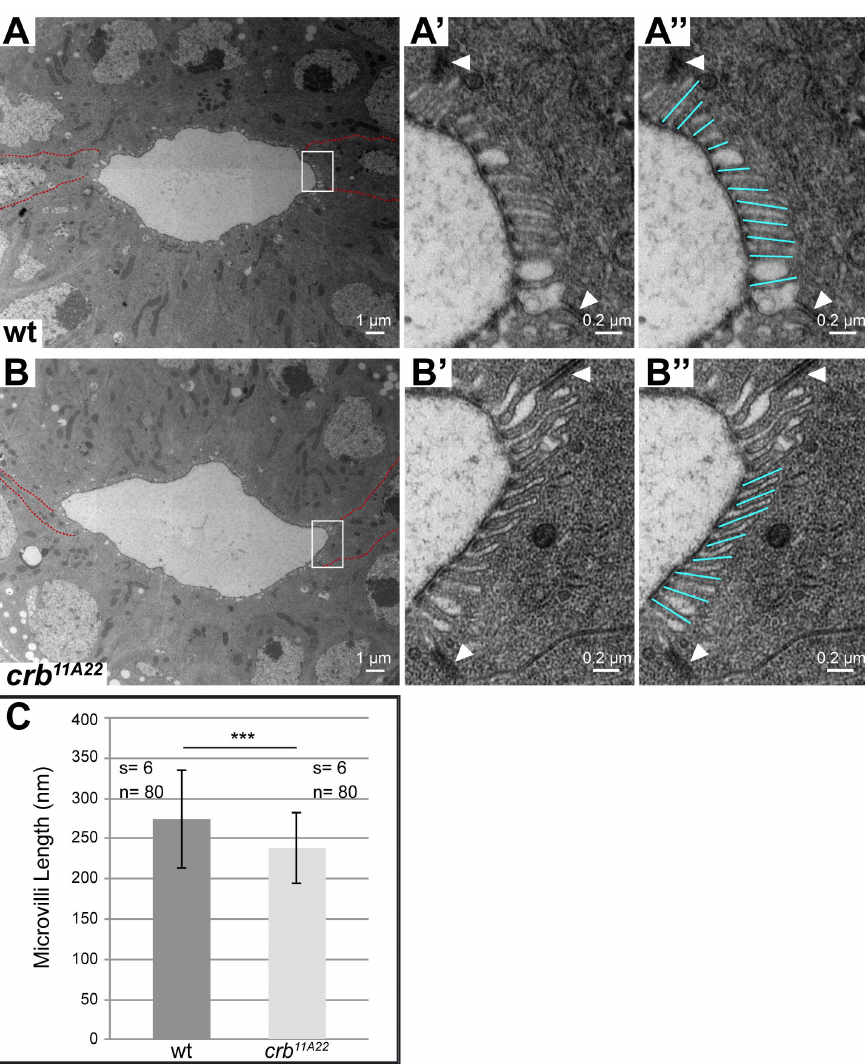
Figure 5. Loss of Crb from the BCs alters the apical membrane structure. ( A–B 0 ) Electron micrographs of cross sections through the large intestines of stage 16 wild-type (A–A 0 ) and homozygous mutant crb 11A22 (B–B 0 ) embryos. In A and B, BCs are outlined by red lines, the rectangles indicate areas enlarged in A 9 , A 0 , B 9 and B 0 . White arrowheads in A 9 , A 0 , B 9 and B 0 point to the adherens junctions between the BCs and PCs. BCs form longer and more regular microvilli than the PCs in wild-type (A–A 0 ) and homozygous crb 11A22 mutant embryos (B–B 0 ). ( C ) Graph showing the mean length of microvilli in the BCs of stage 16 wild-type and crb 11A22 mutant embryos 6 standard deviation. s refers to the number of embryos analysed; n refers to the number of microvilli analysed. ***indicate p-value , 0.001, assessed by two-sided Student’s t-